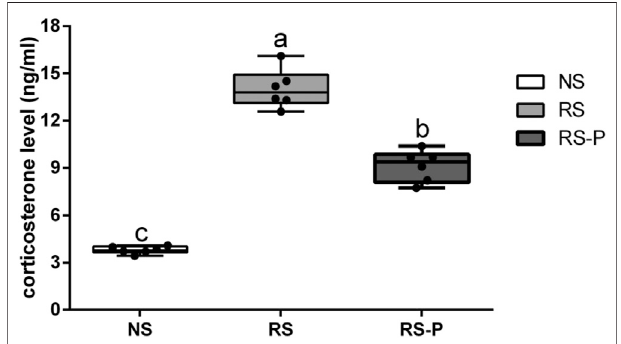
FIGURE 5 | Levels of corticosterone in the serum. Data are presented with the means ± standard deviation ( n (cid:2) 6). Bars with different letters are signi fi cantly different on the basis of Duncan ’ s multiple range test ( P <